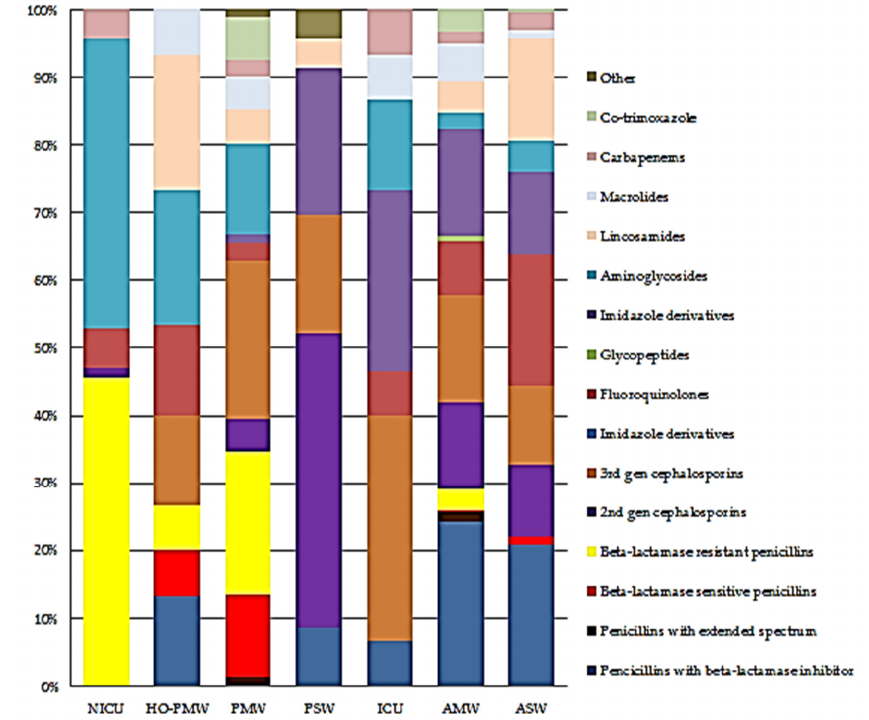
Figure 1. Proportional antibiotic use (J01) by class on wards. Abbreviations: NICU: neonatal intensive care unit, HO-PMW: haematology–oncology–paediatric medical ward, PMW: paediatric medical ward, PSW: paediatric surgical ward, ICU: intensive care unit, AMW: adult medical ward, ASW: adult surgical ward.